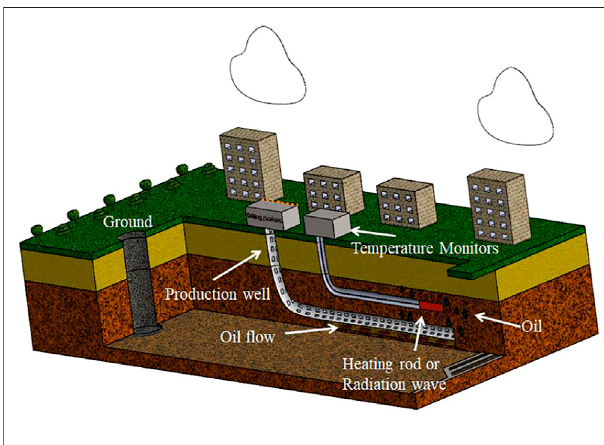
FIGURE 1 | Underground re fi